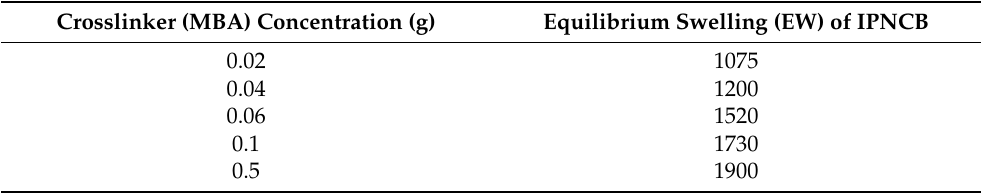
Table 4. Optimization crosslinker concentration in CMC-g(TerPolys)/BC superabsorbent compo-